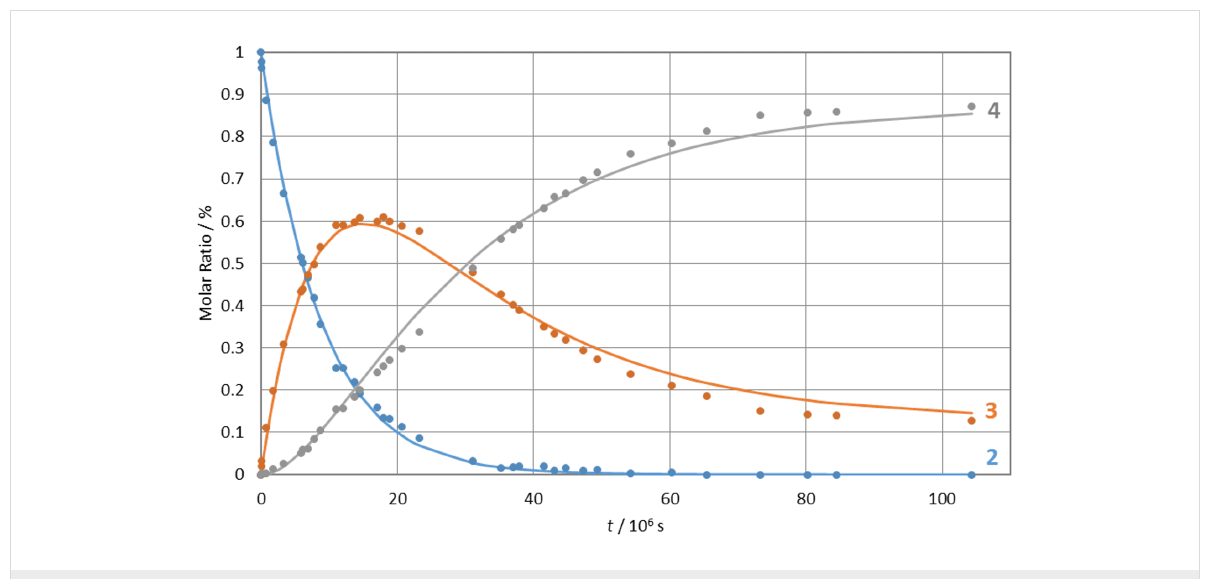
Figure 3: Interconversion kinetics of compounds 2 (blue), 3 (orange) and 4 (grey).